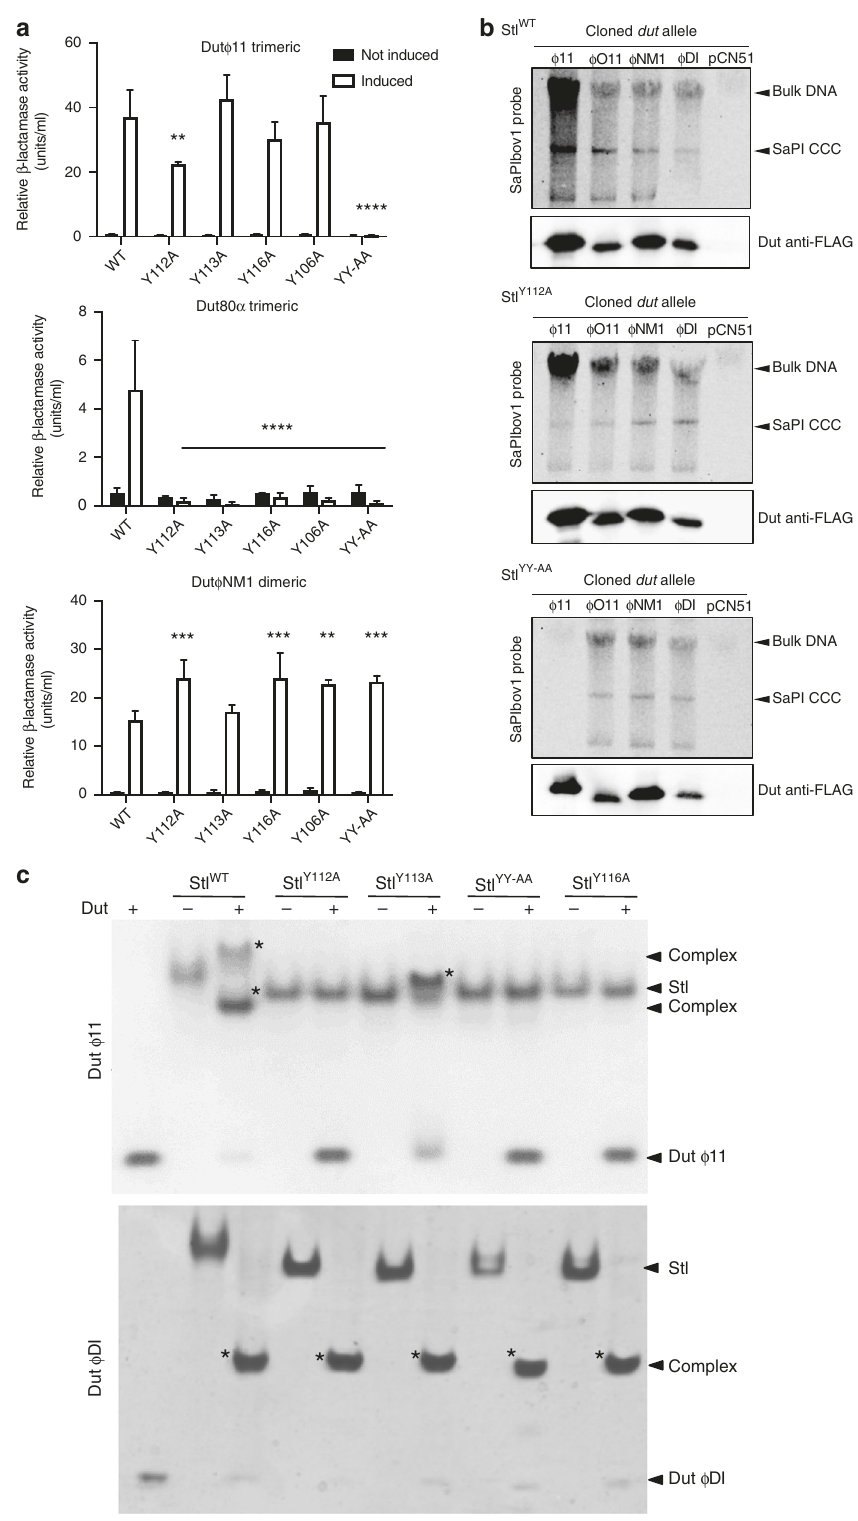
together with either Duts encoded on the cadmium-inducible overexpression vector pCN51 or with the phages encoding speci fi c Dut genes (see Methods for more details). When the trimeric Dut ϕ 11 was overexpressed from the P cad promoter on pCN51 in the Stl YY-AA mutant strain, SaPIbov1 induction was extraordinarily reduced in comparison to the WT SaPIbov1 island (Fig. 4b). Interestingly, the trimeric Dut ϕ 11 was able to